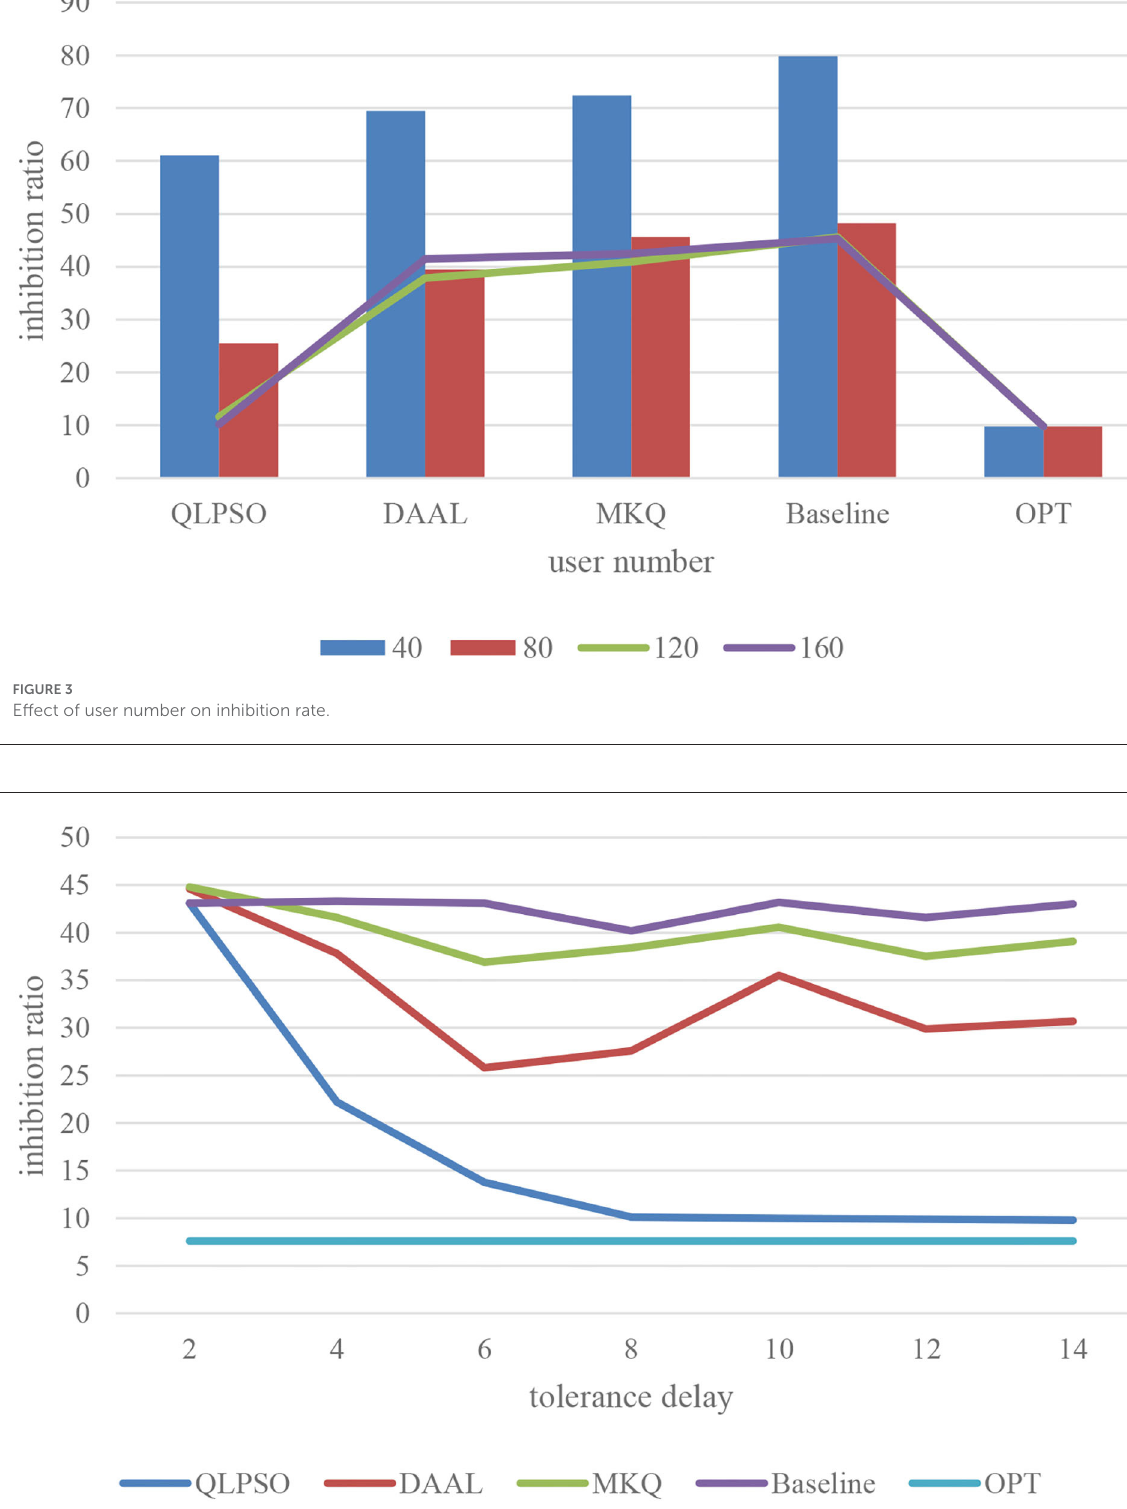
FIGURE4 Effect of tolerance delay on inhibition